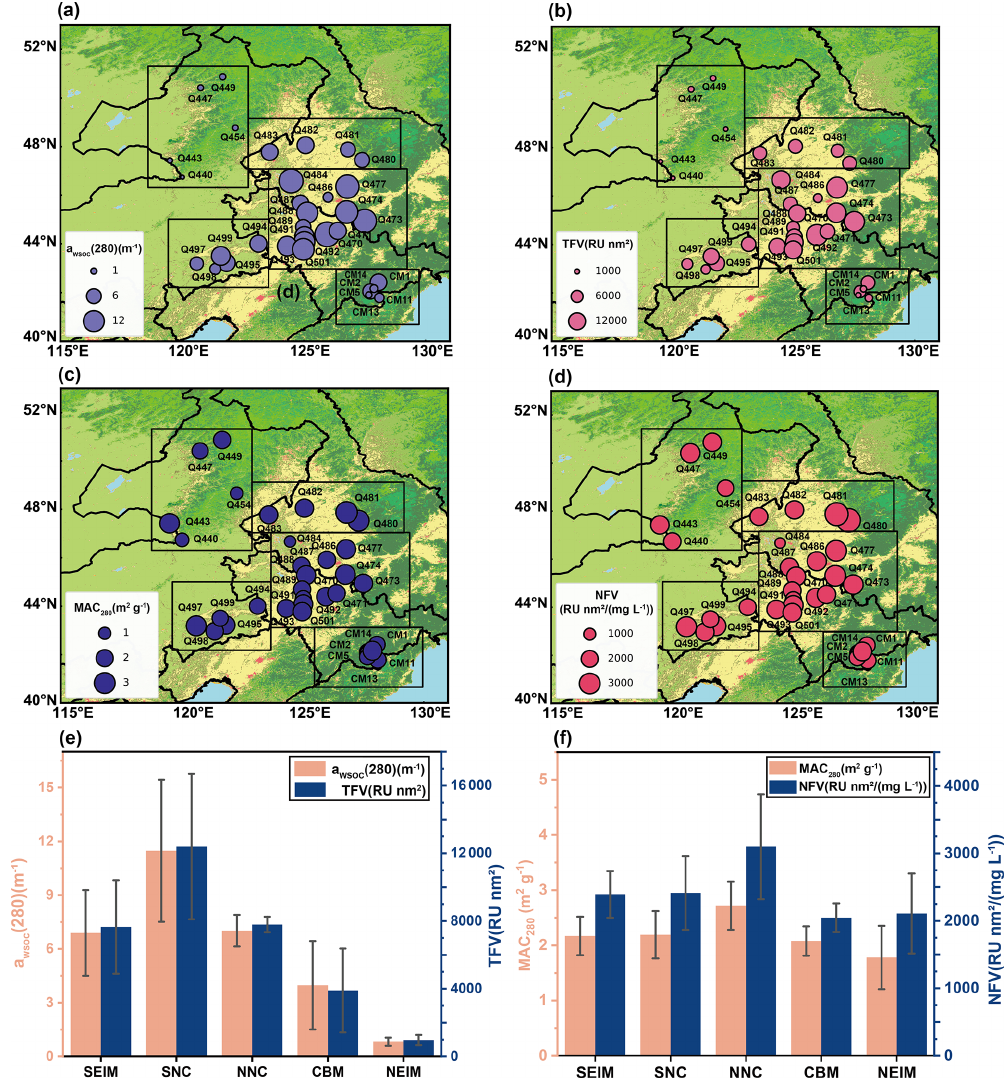
Figure 5. Spatial distribution of (a) a WSOC (280) (m − 1 ), (b) TFV (RUnm 2 ), (c) MAC 280 (m 2 g − 1 ), and (d) NFV (RUnm 2 (mgL − 1 ) − 1 ). Regional averages for (e) a WSOC (280), TFV, and (f) MAC 280 , NFV, for the five groups. Error bars in (e) and (f) represent the standard deviations of a WSOC (280), MAC 280 , TFV, and NFV for the five groups,